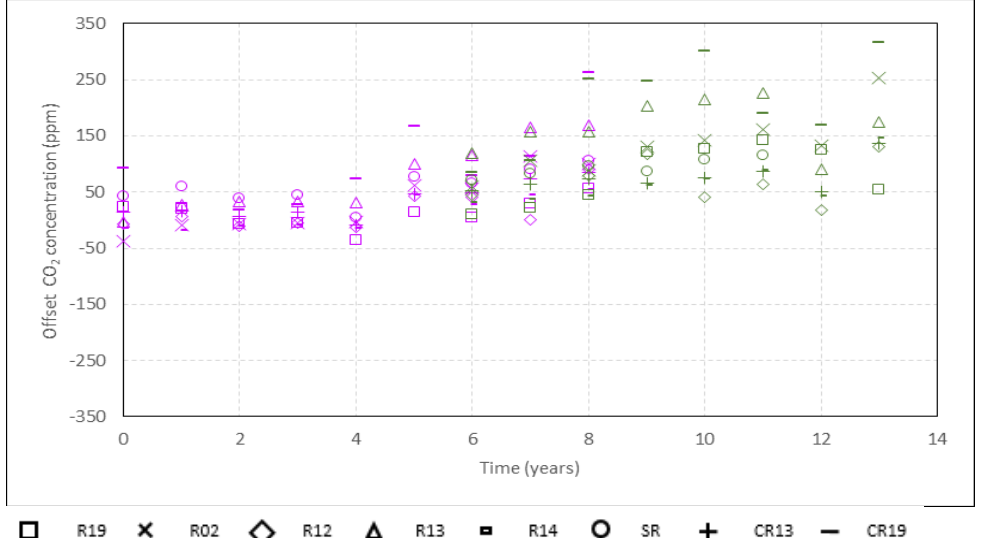
Figure 3. Difference in daily mean values of the CO 2 concentration between Ext and R01 Ref sensors during unoccupied periods of summer (red) and winter (blue), and spread of the measurements (grey) obtained as the standard deviation of the mean daily mean values of the CO 2 concentration between R13, R01, R02, R12, R13, R14, SR, CR13, CR19 and R01 Ref CO 2 sensors during unoccupied periods in August. The 0 in the x -axis corresponds to the year 2008.